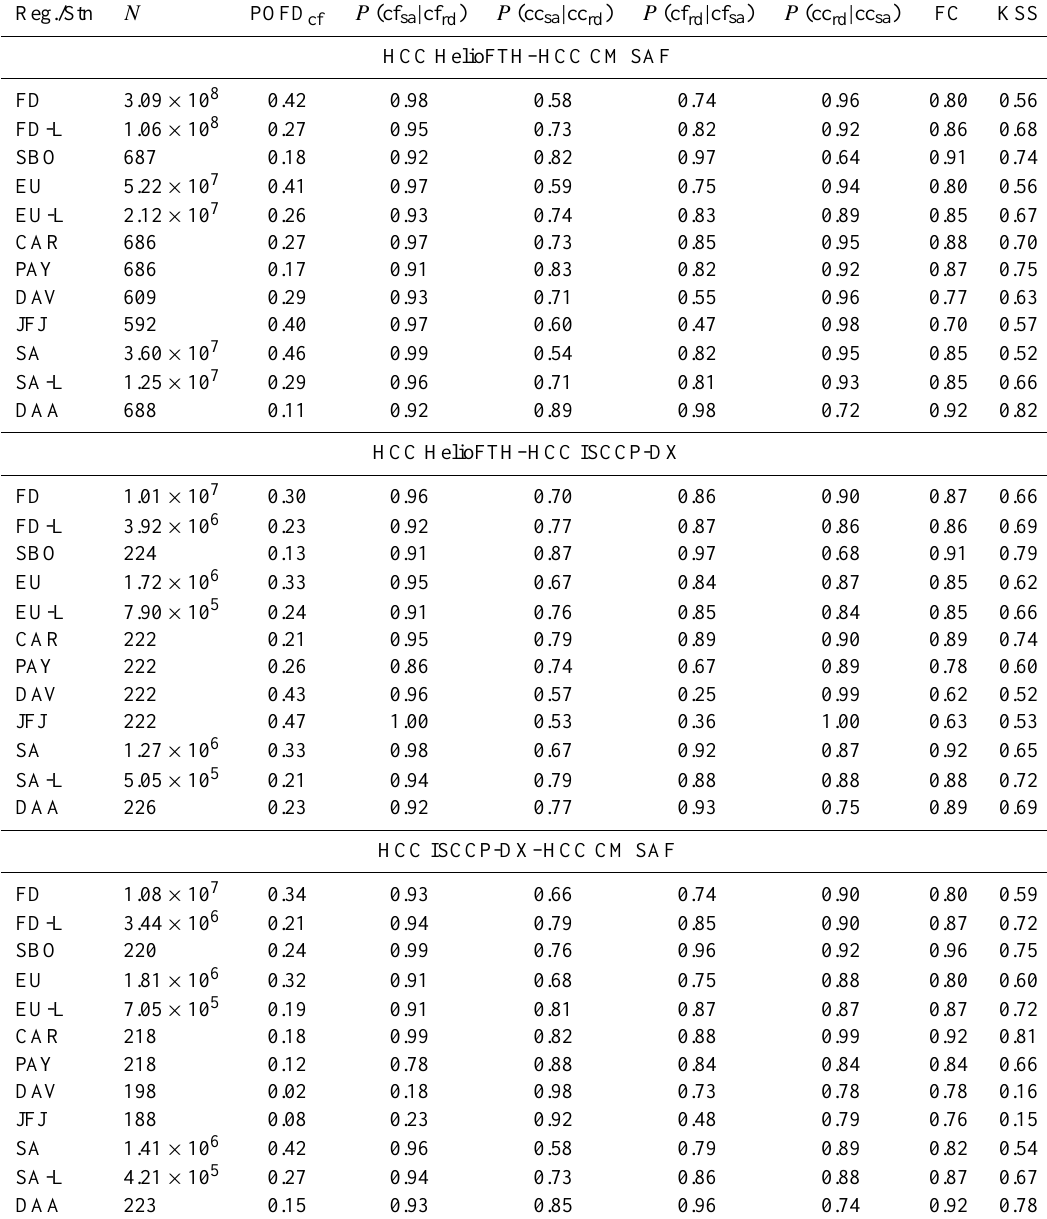
Table 6. Results of the middle and high cloud coverage (HCC) product inter-comparison for full disk (FD), Europe (EU), South Africa (SA) and for all sites with synop observations from Table 1 for April 2004. Suffix “L” indicates pixels over land only, N =the number of compared values, FC=fraction correct and KSS=Kuiper Skill